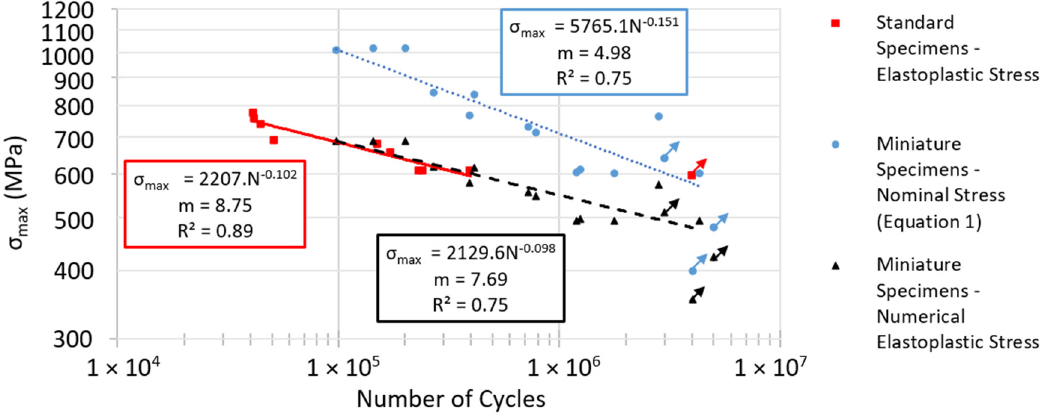
Figure 14. S-N curves, standard and miniature specimens, R = 0.1.